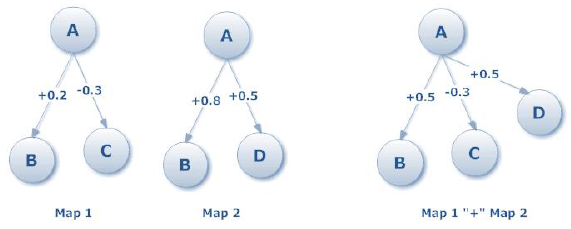
Fig. 9. Combining two basic